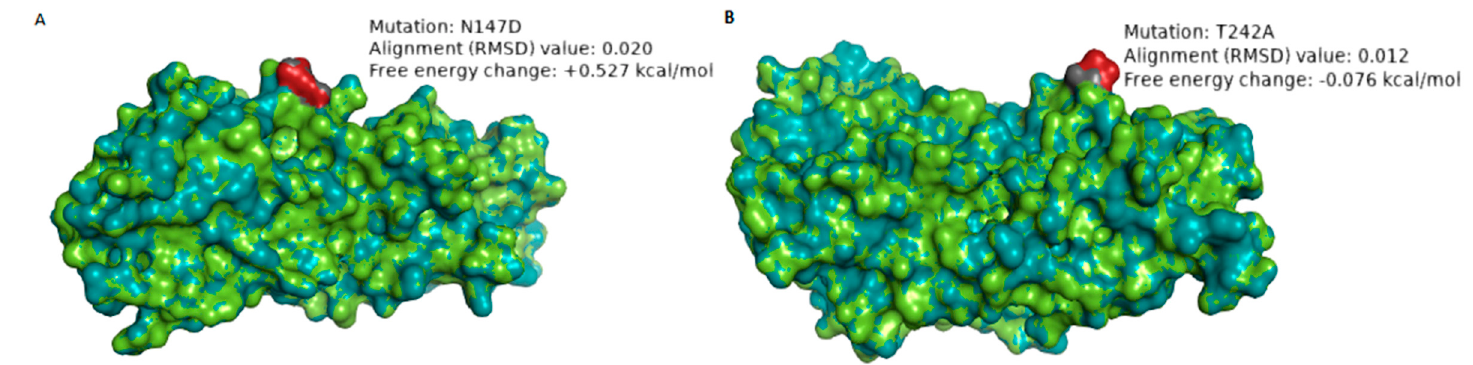
Figure 3. Structure models showing the mutation sites N147D ( A ) and T242A ( B ), respectively, that were only present in post-vaccine G1P[8] strains when superposed with VP7 of Rotarix ® . The structure of the study strain is in green, while the Rotarix ® structure is in deep-teal. The amino acid residues are represented in dark gray and red to examine whether the replacing amino acid alters the conformation of the protein structure. The amino acid residue highlighted in dark gray represents the study strain while that in firebrick red represents the Rotarix ® strain. RMSD is the superposition value where the value of zero indicates absolute similarity. The stability of the protein after mutation was measured in kcal/mol, whereby free energy change of ±0.5 kcal/moL was regarded as significant for the stabilizing/destabilizing effect.